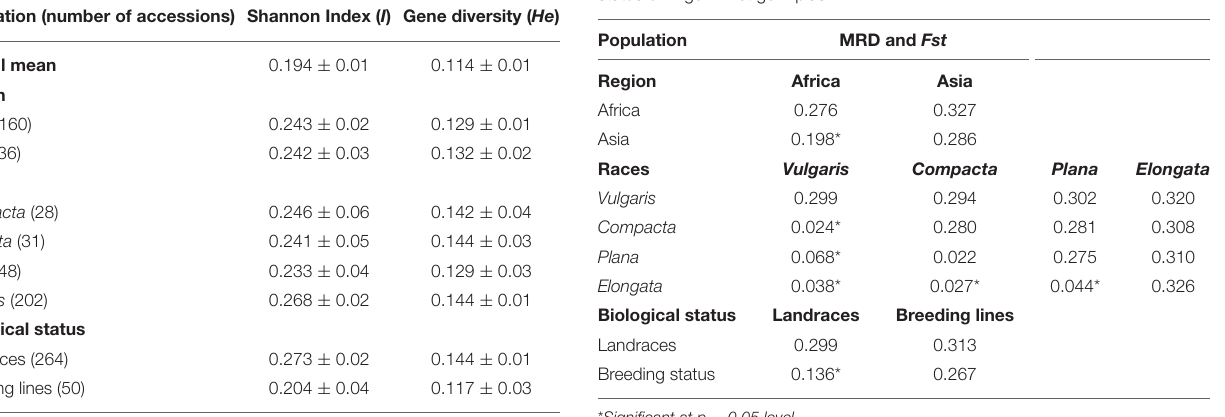
TABLE 1 | Shannon diversity index and gene diversity for the entire set, regions, races, and biological status of finger millet germplasm.